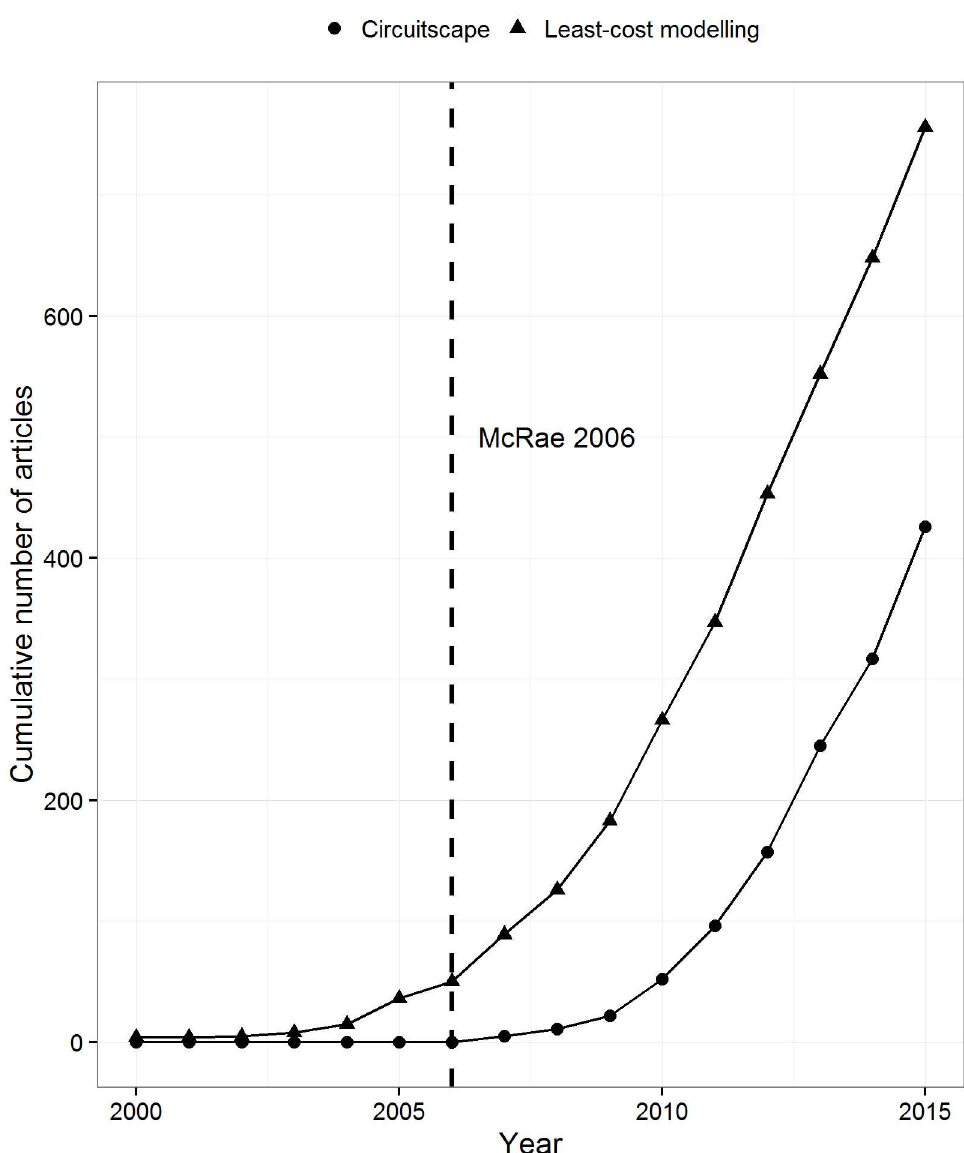
Fig 1. The use of least-cost modelling and circuit theory in ecology. Cumulative increase in the numberof Google Scholar articles that have mentioned Circuitscape and least-cost modelling in the field of Ecologysince